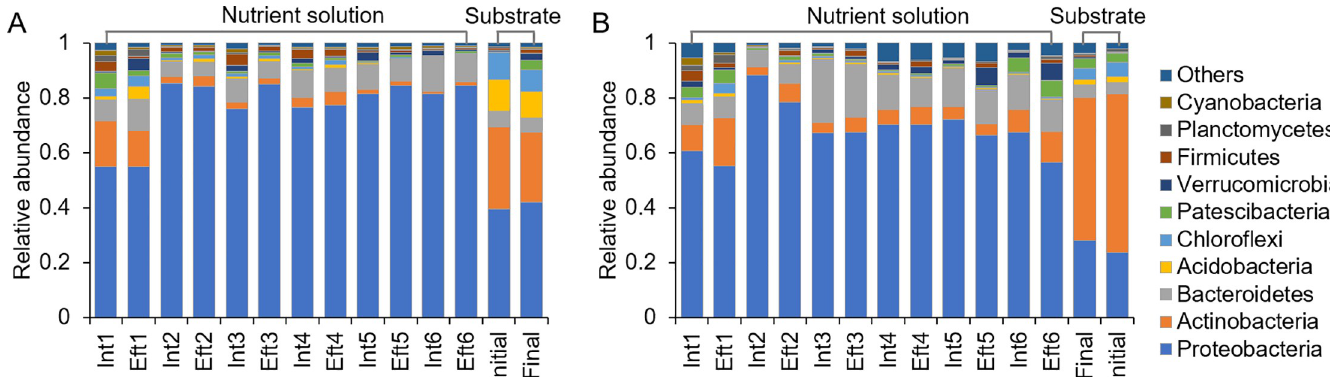
Fig 4. Distribution of bacterial communities at the phylum level in the recirculating nutrient solution and substrate samples of cucumber plug seedlings cultivated in an ebb-and-flow system in summer (A) and winter (B). Int and Eft represent the influent and effluent nutrient solution samples, respectively.